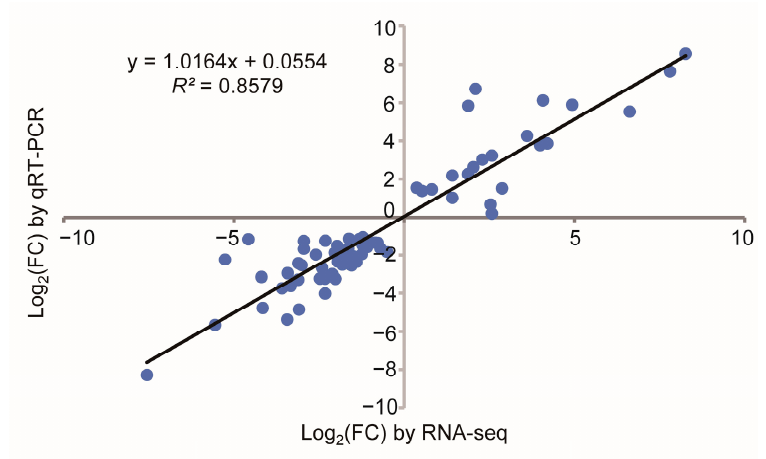
Figure 5. Association analysis on 38 selected transcripts between RNA-Seq and qRT-PCR.